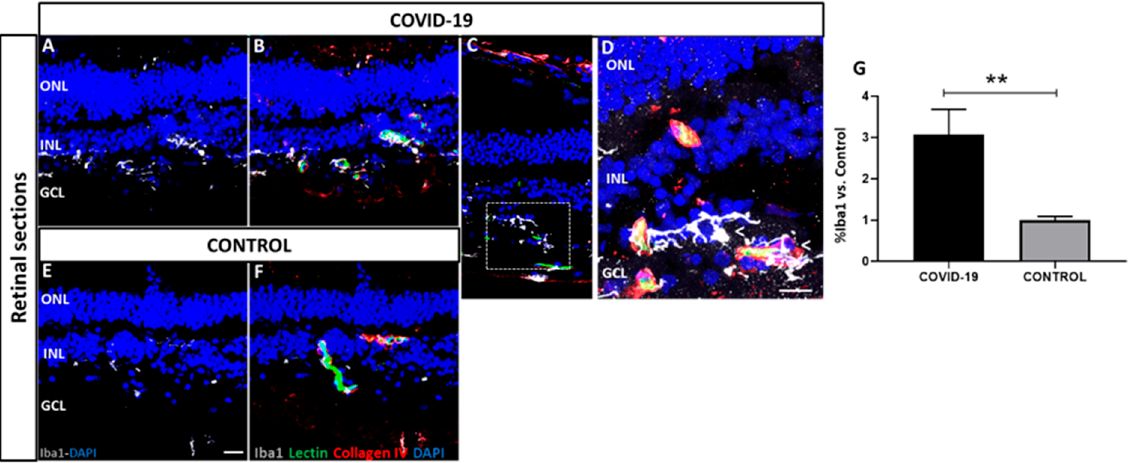
Figure 5. Localization and quantification of ionized calcium-binding adaptor molecule 1 (Iba1) (white) in COVID-19 ( A – D ) and control retinal cross-sections ( E , F ) previously labelled with lectin (green) and collagen IV (red). In contrast to controls ( E , F ), COVID-19 retinas ( A – D ) exhibited very strong Iba1 staining. Boxed region in ( C ) is shown at higher magnification in ( D ). DAPI (blue) label nuclei. ( G ) Percentage of Iba1 signal intensity from COVID-19 retinas vs. controls. ** p < 0.01. Scale bar: 100 µm. Arrows indicate areas of microglial activation. Abbreviations: GCL (ganglion cell layer), INL (inner nuclear layer), ONL (outer nuclear layer).